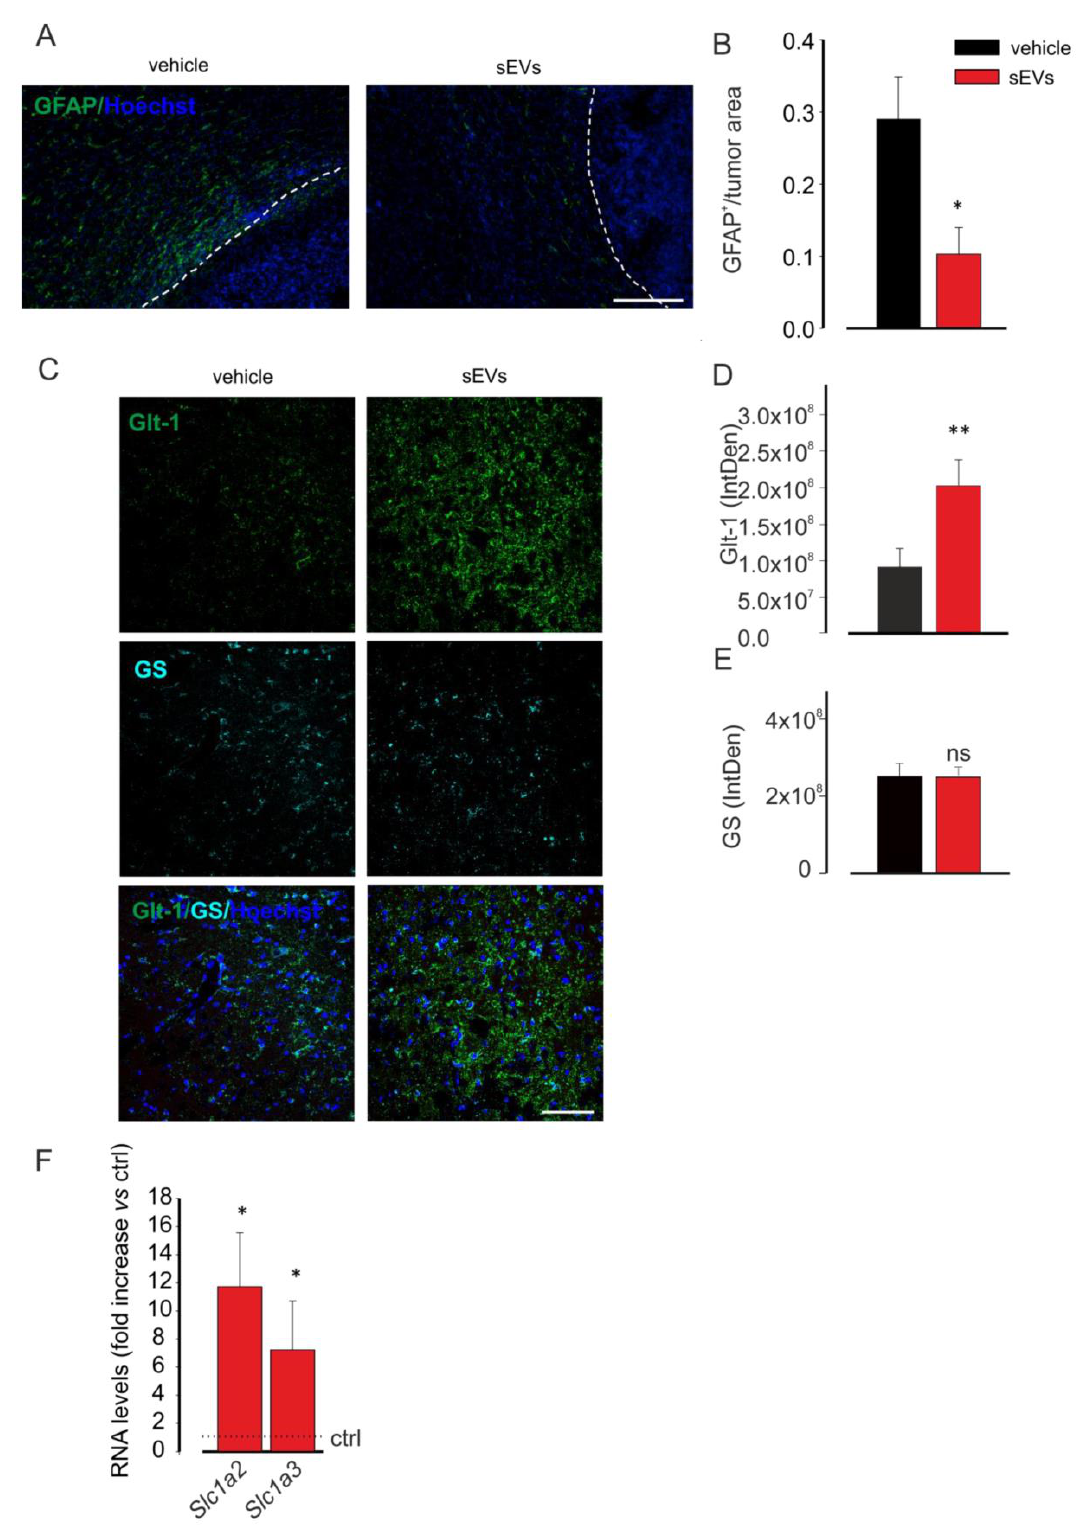
Figure 2. Microglia-derived sEVs effects on astrocytes. ( A ) Representative immunofluorescence analysis for glial fibrillary acidic protein (GFAP in green; Hoechst in blue) of coronal brain sections of GL261-bearing mice vehicle treated (on the left) or treated with BV2-derived sEVs (on the right). The tumor region is on the right of the dashed line. Scale bar: 20 μm. ( B ) Quantification of ( A ). Data are expressed as the signal coverage area of GFAP normalized by tumor area